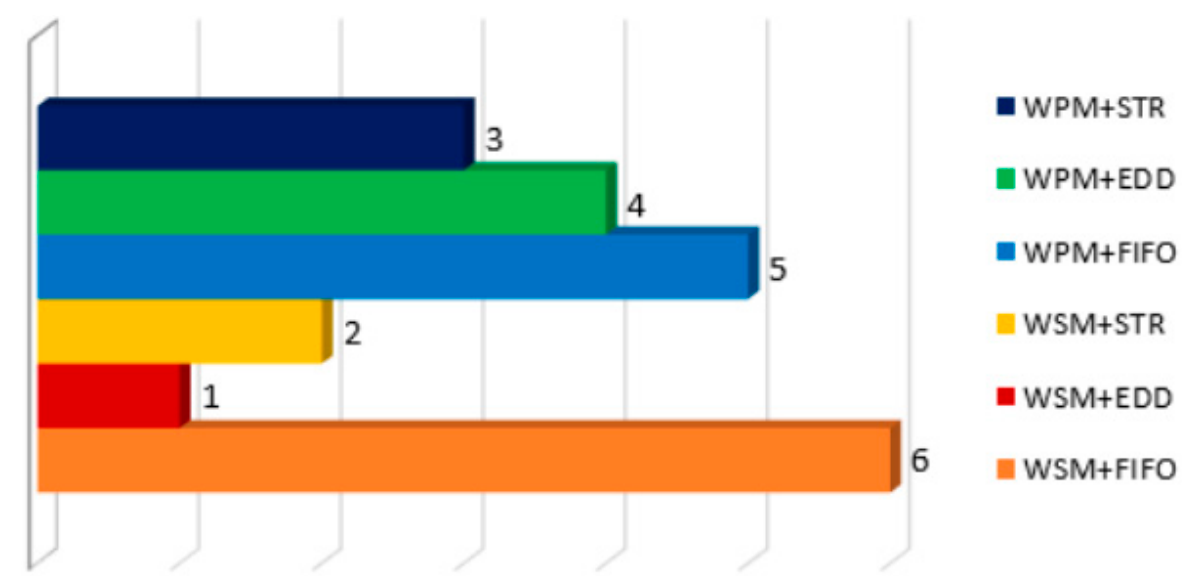
Figure 5. Ranking of applied methods of multi-criteria optimization in the conjunction with selected priority rule.